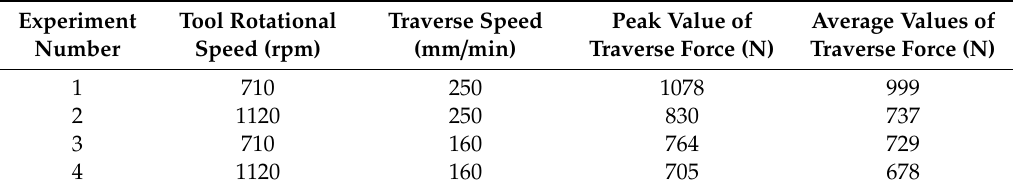
Table 6. Peak values of traverse force for different welding parameters.